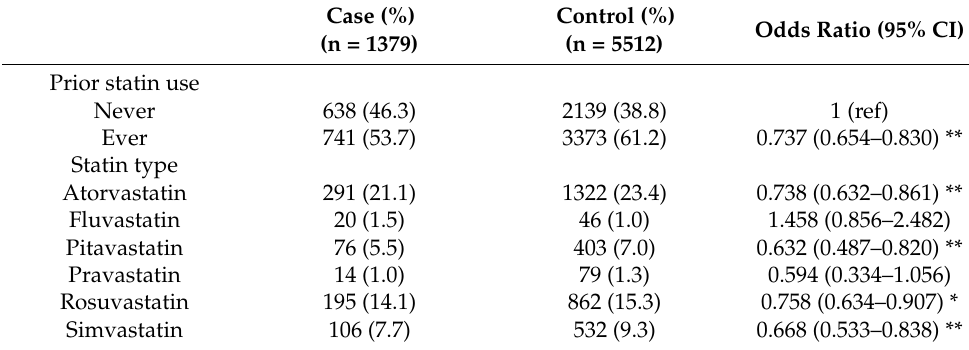
Table 2. Association between statin use and risk of sensorineural hearing loss or tinnitus by statin types.